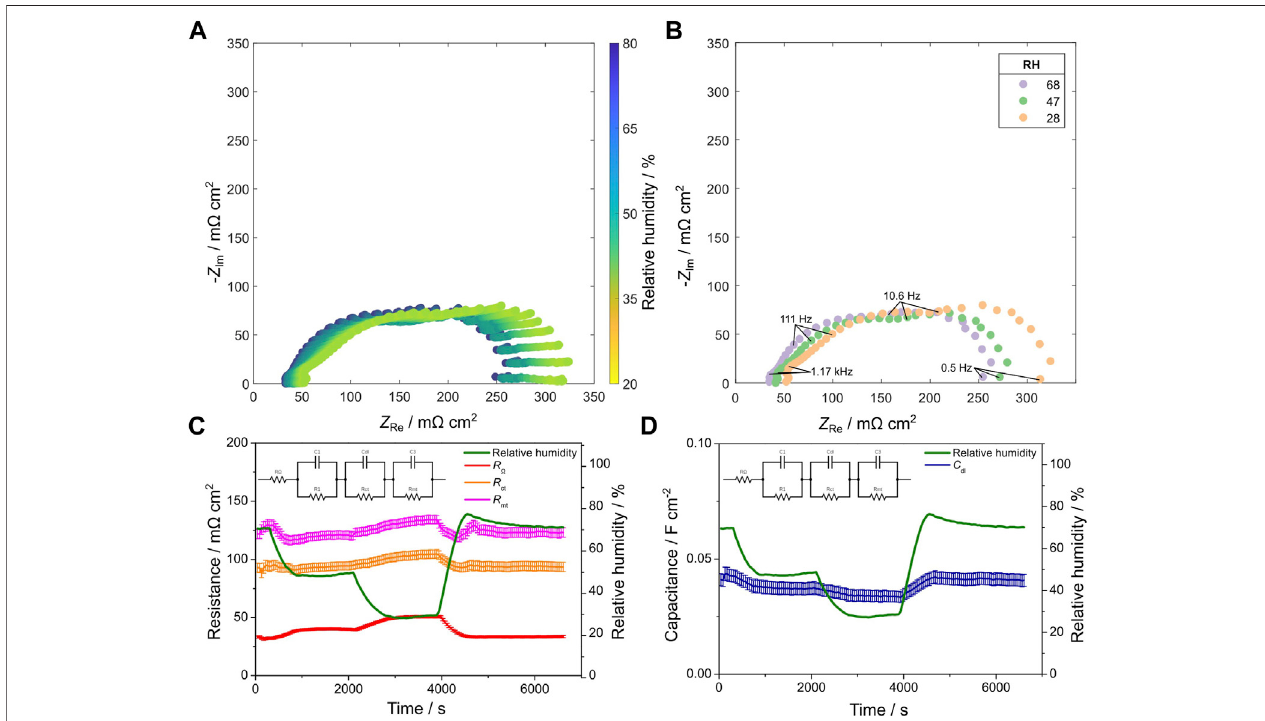
FIGURE 4| EIS spectra and fi tted values from changes in relative humidity; (A) Nyquist plot ofall measurements, (B) Nyquist plot ofselected measurementsat the relative humidity setpoints, (C) fi tted resistance values and relative humidity as a function of time, and (D) fi tted capacitance value and relative humidity as a function of